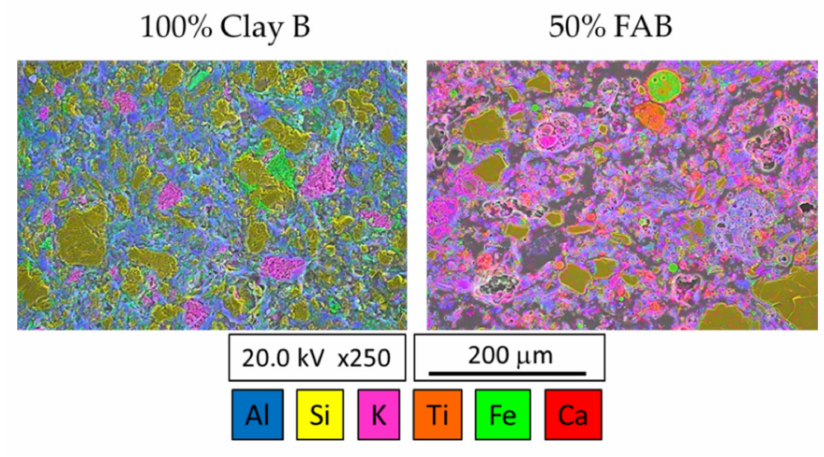
Figure 10. FESEM images and mapping of elements of samples 100% clay B and 50% FAB/clay B.